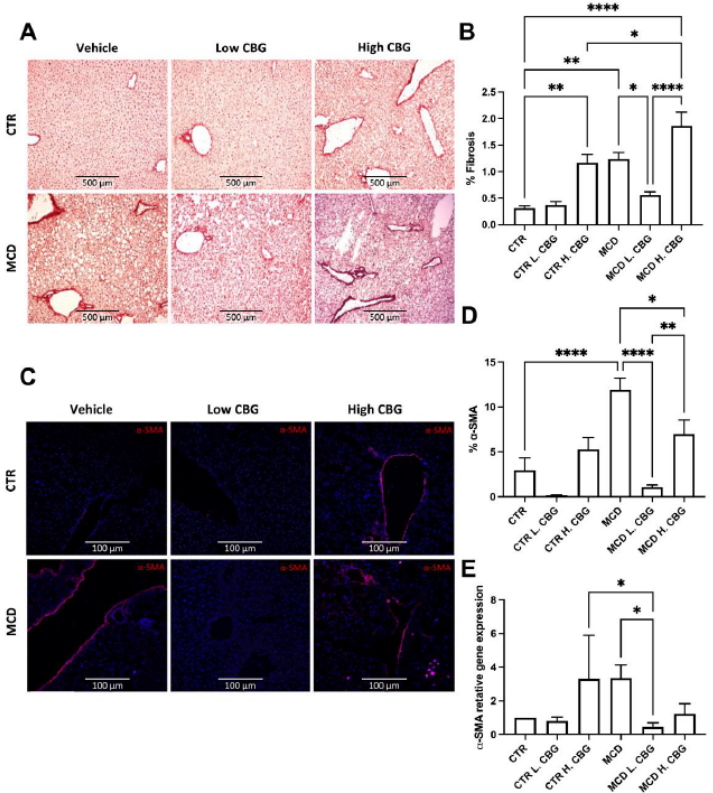
Figure 4. Liver fibrosis was measured by Picro-Sirius Red staining, α -SMA staining and mRNA gene expression. Representative pictures and quantification of collagen deposition in liver frozen section ( A , B , 10 × ). α -SMA immunofluorescence staining and quantification ( C , D , 20 × ) showing α -SMA in red and DAPI (nucleus) in blue ( D ). Quantification of α -SMA mRNA gene expression ( E ). * p < 0.05, ** p < 0.01, **** p <